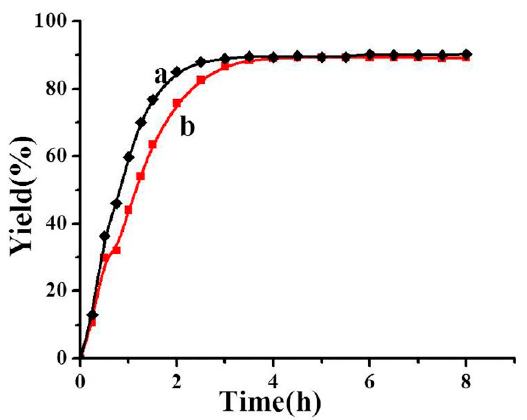
Figure 5. Temporal evolution of Aldol reaction catalyzed by ( a ) L-proline / MWCNTs and ( b ) L-proline.